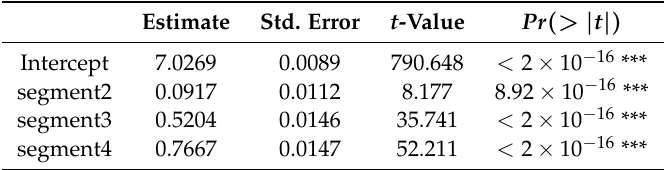
Table 3. Regression coefficients with three breakpoints: the label *** indicates significance of the test values at the 99% level of